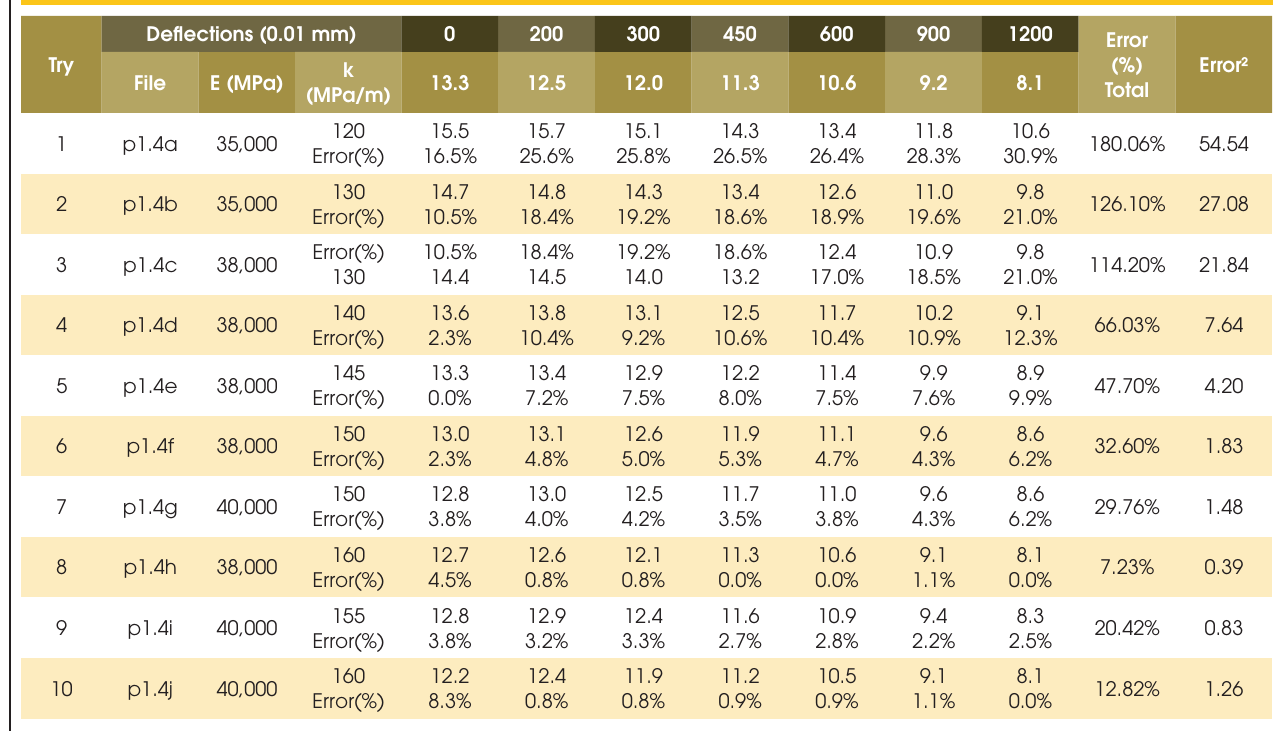
Table 2 – Deflections matching process for point P1.4